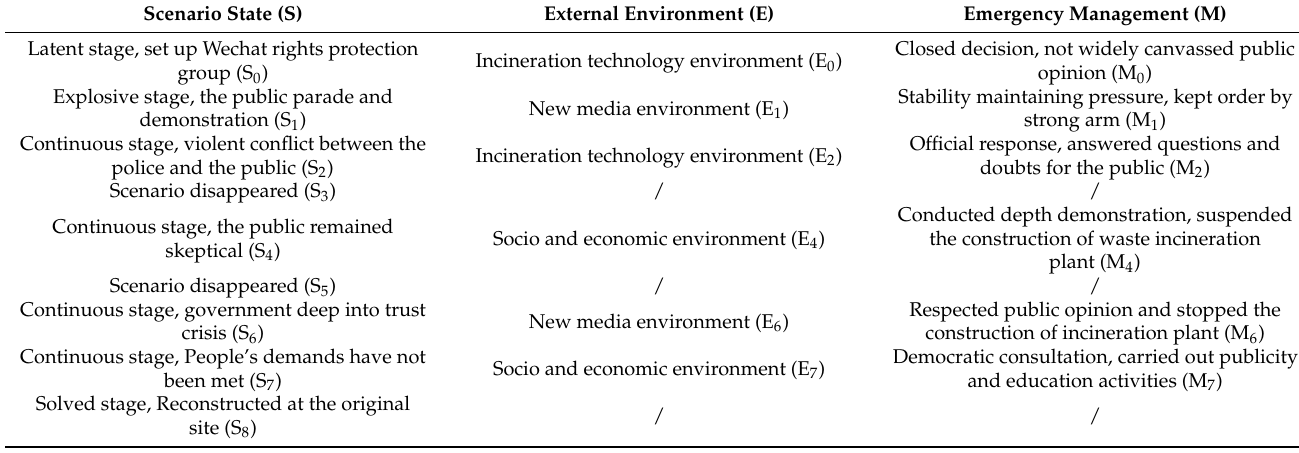
Table 3. Scenario network node variables.